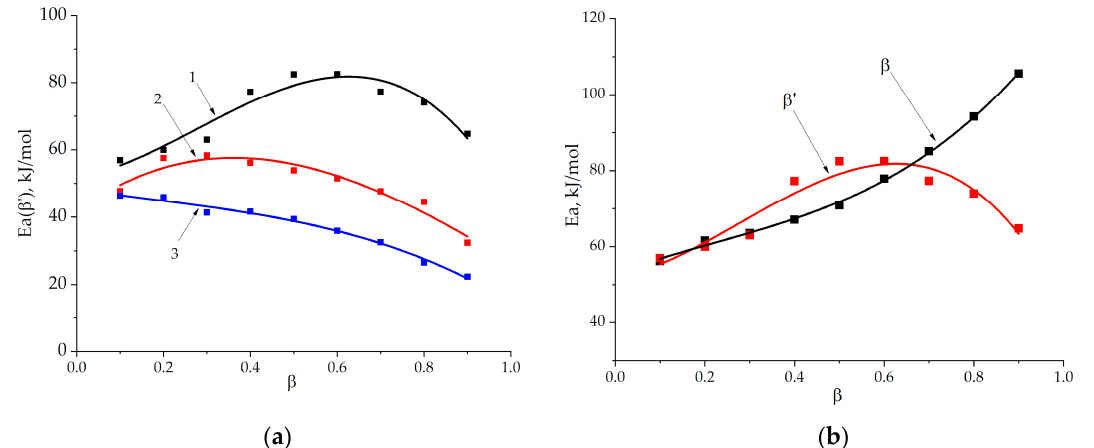
Figure 9. The Ea-dependencies (Ea) on the relative degree of conversion ( β ’) calculated by the Friedman method for formulations 1–3 ( a ). A comparison of Ea-dependencies calculated by the Friedman method for formulation 1 using absolute ( β ) and relative ( β ’) degrees of conversion ( b ).